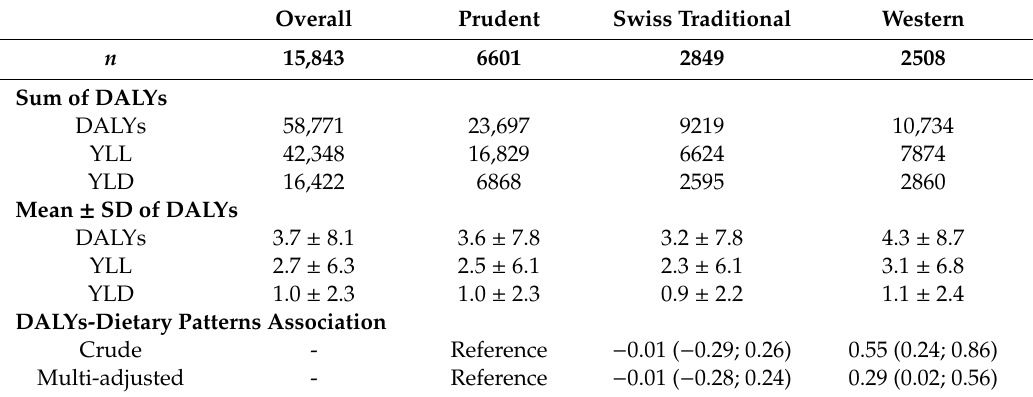
Table 3. DALYs due to noncommunicable diseases and DALYs-dietary patterns association in the NRP–MONICA